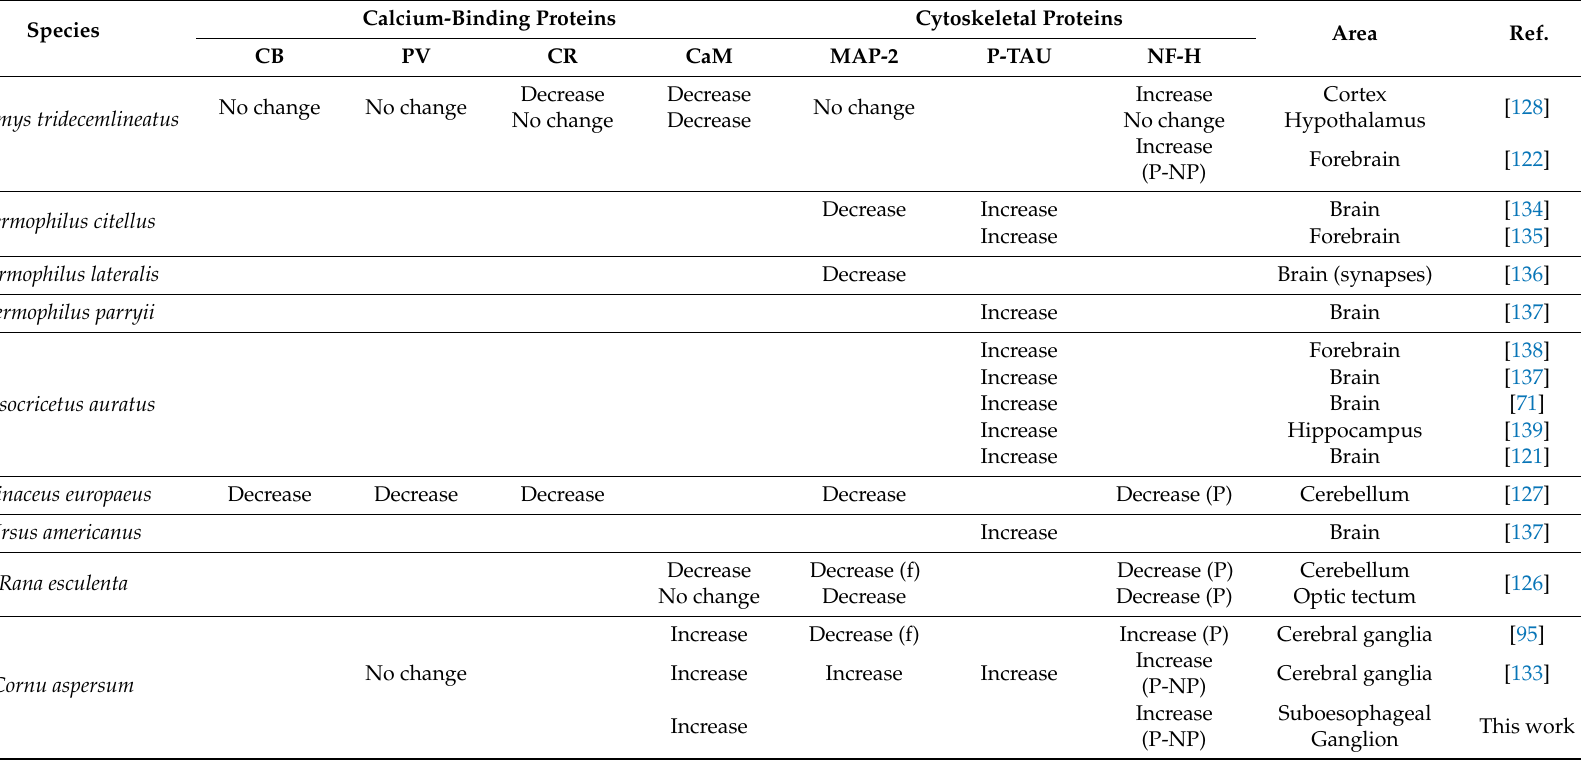
Table 1. Changes in CBPs and cytoskeletal proteins during hibernation in vertebrates and